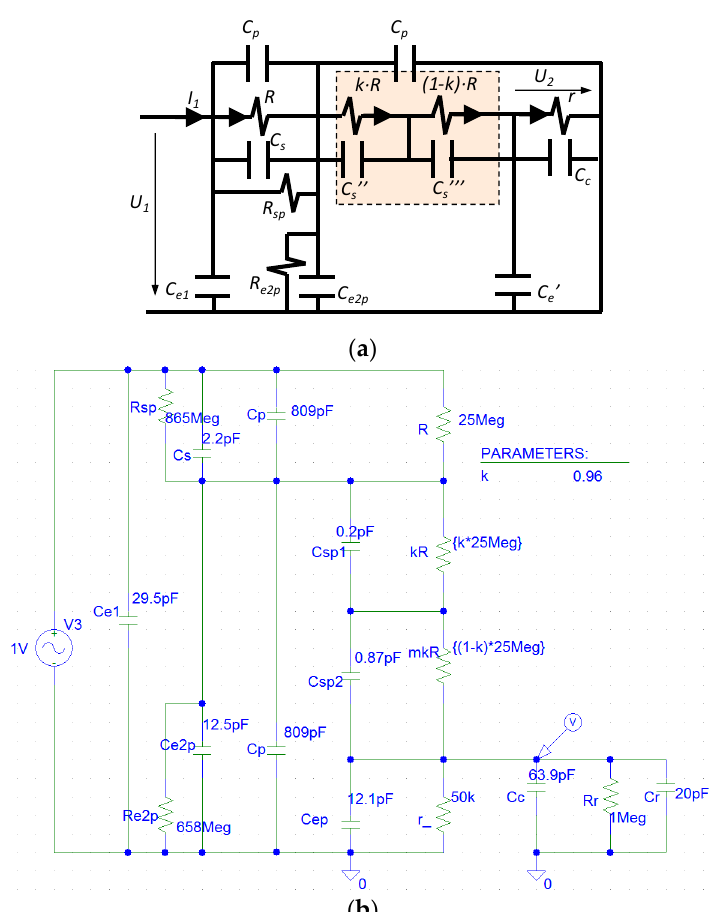
Figure 9. Improved model of the sensor: ( a ) equivalent electric circuit; ( b ) PSPICE model to fit the frequency response to the measured one.